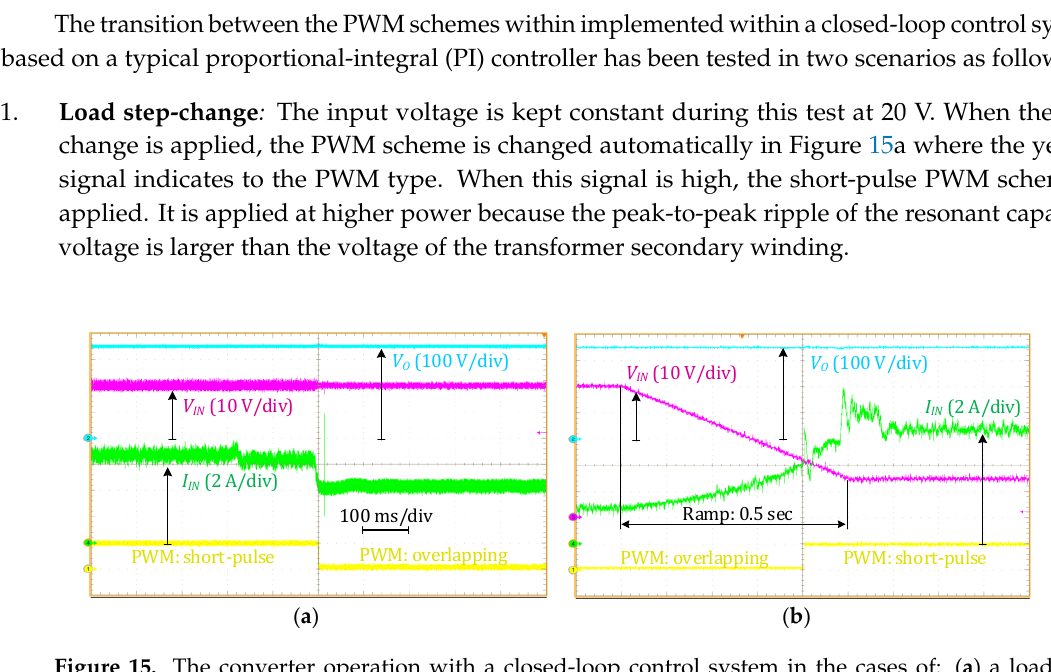
Figure 14. Block diagram describing the implementation of transitions between the two PWM schemes based on the empiric Equation (18).